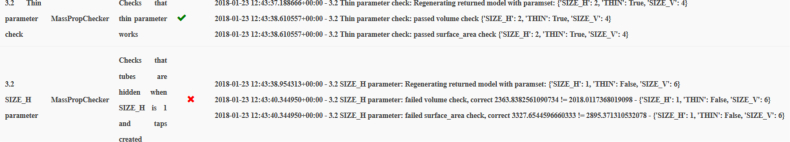
A part of summary table showing what checks were run and what the result was.